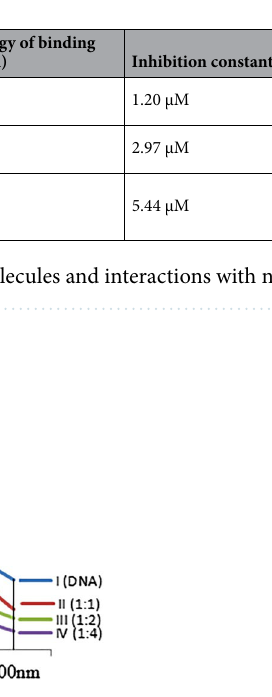
Figure 8. UV absorption spectrum of DNA and AFM 1 -DNA complex.